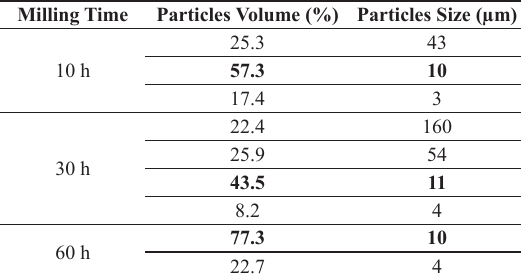
Table 2. Laser granulometry results obtained for X22CrMoV12-1 alloy + VC after milling. Milling